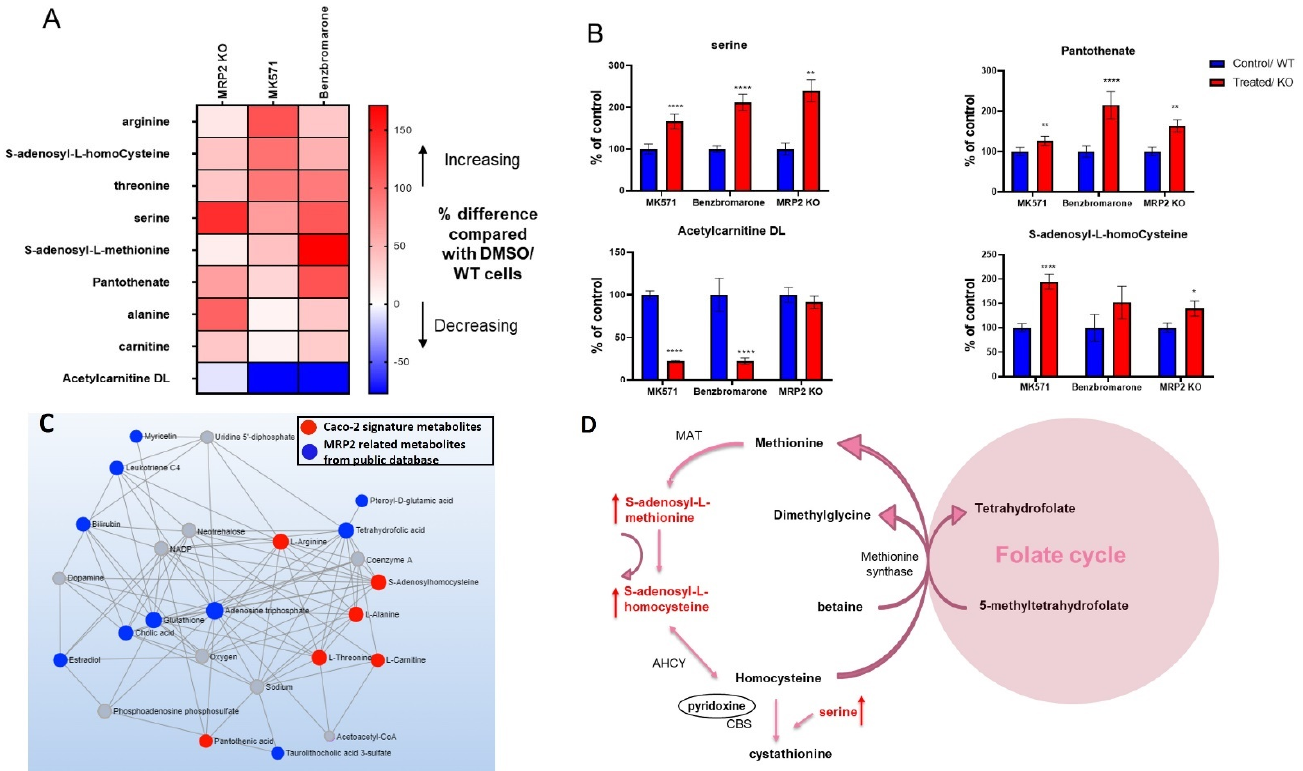
Figure 4. Heat map ( A ) and bar graphs ( B ) representing changes in metabolites in cells treated with MRP2 inhibitors and MRP2 KO cells. The data represent changes in metabolites in response to MRP2 KO and MRP2 inhibition by MK571 (200 µM) and benzbromarone (66.6 µM). The data representing changes with MK71 inhibition were acquired from 3 individual experiments, and each experiment was performed with a minimum of 6 replicates and presented as the mean of 3 repeats. The data from benzbromarone and MRP2 KO represent the mean of 1 independent experiment, which was performed with at least 6 replicates. ( A ) The data are presented as the percentage change compared with control (DMSO/WT). ( B ) The data were normalized by dividing the mean (peak area) of treated/KO group with the control group and are presented as a percentage (mean ± SEM) of the control group. Significance of these results was determined using Mann–Whitney test and results with * p < 0.05, ** p < 0.01, **** p < 0.0001 were considered significant. ( C ) Metabolite–metabolite network analysis based on MRP2 signature metabolites identified in our lab (red dots) and MRP2 related metabolites from public database (blue dots) (grey dots: other metabolites in the network generated by MetaboAnalyst). ( D ) MRP2 signature metabolites altered in methionine cycle.